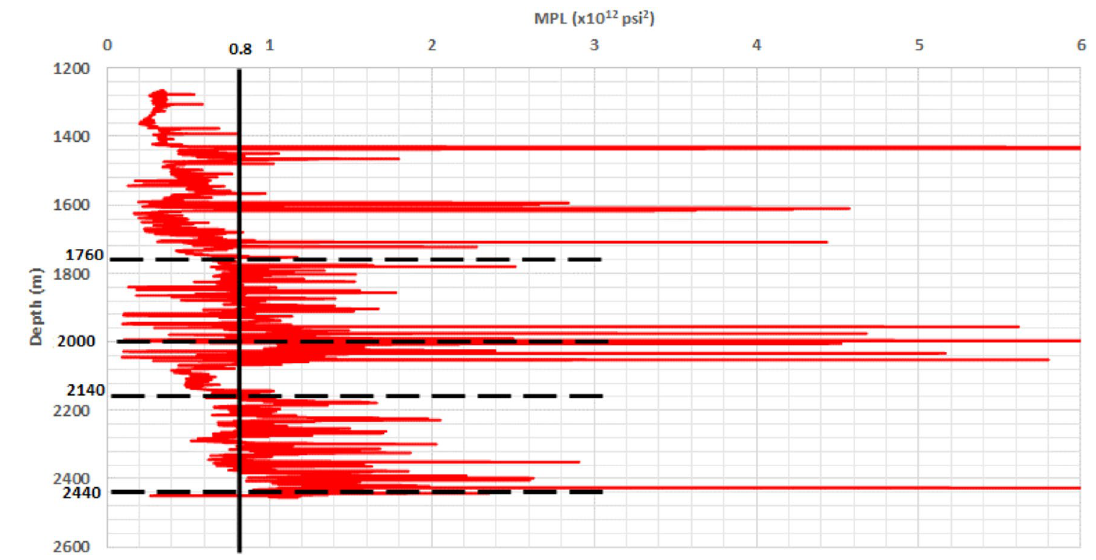
Fig. 14 MPL value of Field Y